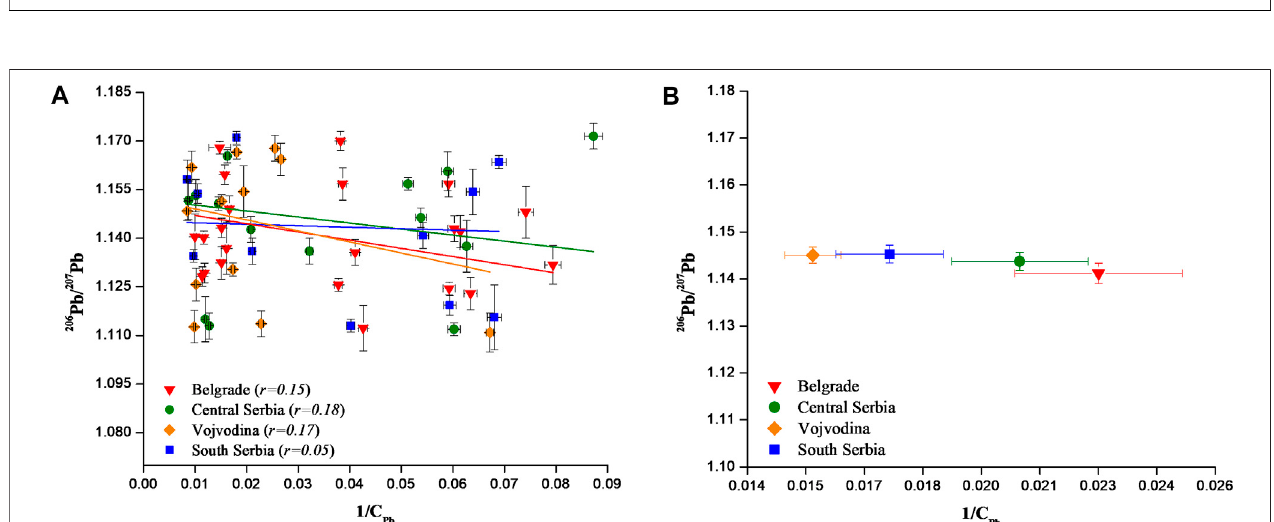
FIGURE 6 | Plot of average 208 Pb/ 206 Pb and average 206 Pb/ 207 Pb of analyzed Serbian wines. Error bars represent standard deviations between samples. Comparison with identical LIRs in aerosols from different European countries. Inset fi gure represent distribution of 208 Pb/ 206 Pb and 206 Pb/ 207 Pb for individual wine samples from four Serbian regions.